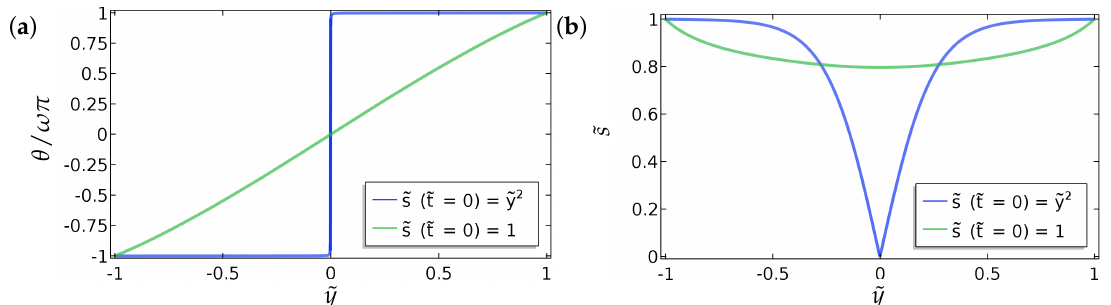
Figure 13. Equilibrium profiles of ( a ) the director orientation, θ and ( b ) the order parameter ˜ s for two different initial conditions for ˜ s and a linear initial profile for θ , without any fluid flow. The blue curves are the equilibrium profiles for θ and ˜ s for ˜ s ( ˜ y ,0 ) = ˜ y 2 and the green curves are the equilibrium profiles for ˜ s ( ˜ y ,0 ) = 1. We have considered the symmetric condition for θ given by Equation (15). The values of the parameters used are ω = 1/2 and L ∗ =